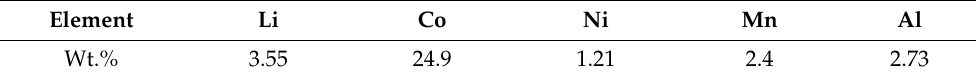
Table 2. Li, Co, Mn, Ni, and Al contents in the cathodic active material of the spent LIBs. Element Li Co Ni Mn Al Wt.% 3.55